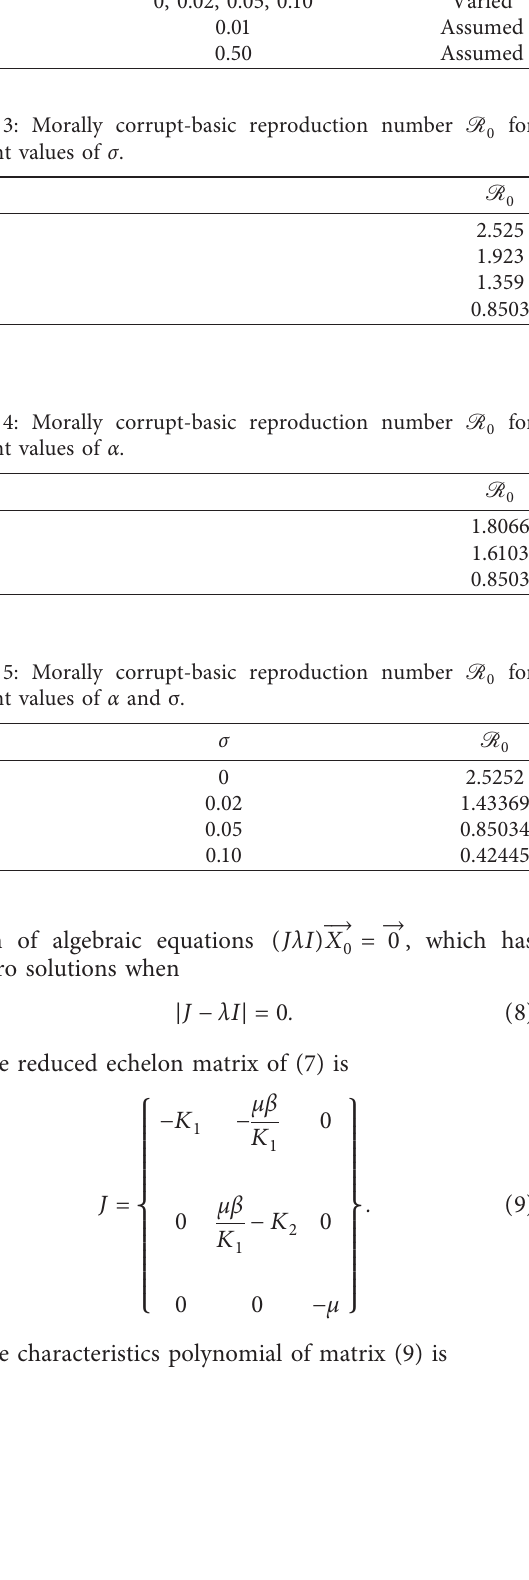
Table 3: Morally corrupt-basic reproduction number R